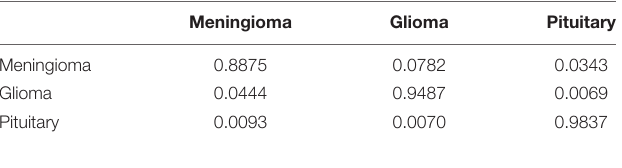
TABLE 1 | Confusion matrix of CDLLC on the Cheng dataset.